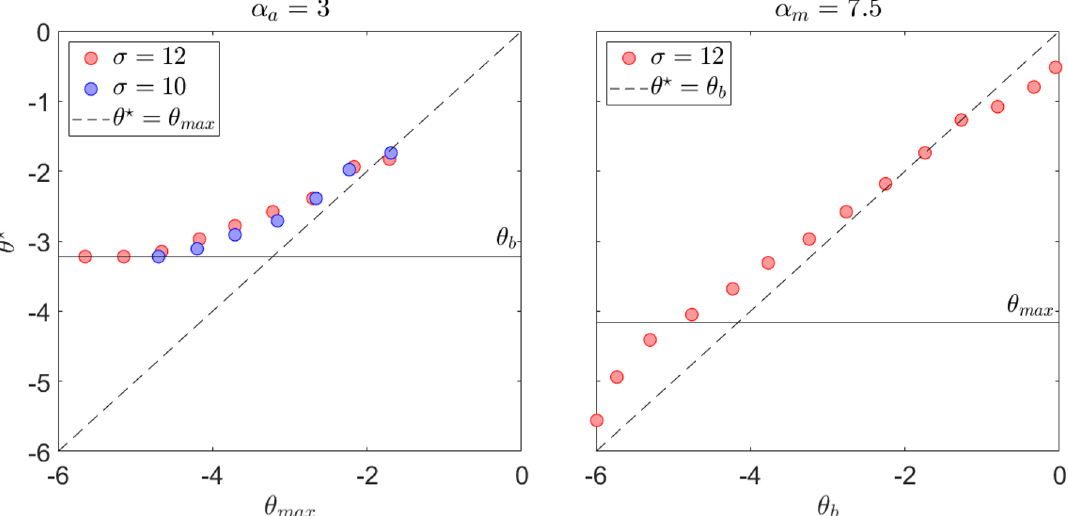
Figure 9 . Left: persistent peak maximum of particle ( + ) position θ ? as a function of the rapidity θ max for which interaction with particles of type ( − ) is maximised. The parameters σ = 12 , 10 and α = 3 are fixed. We observe no significant difference for the two values of σ . The solid black a line indicates the bath maximum position θ , and the dashed line is θ ? = θ . Right: persistent b max peak position θ ? as a function of the bath maximum θ for a fixed parameter σ = 12 and fixed b higher temperature exponent α = 7 . 5 . The solid black line indicates the rapidity maximising the m interaction, θ , and the dashed line is θ ? = θ max b